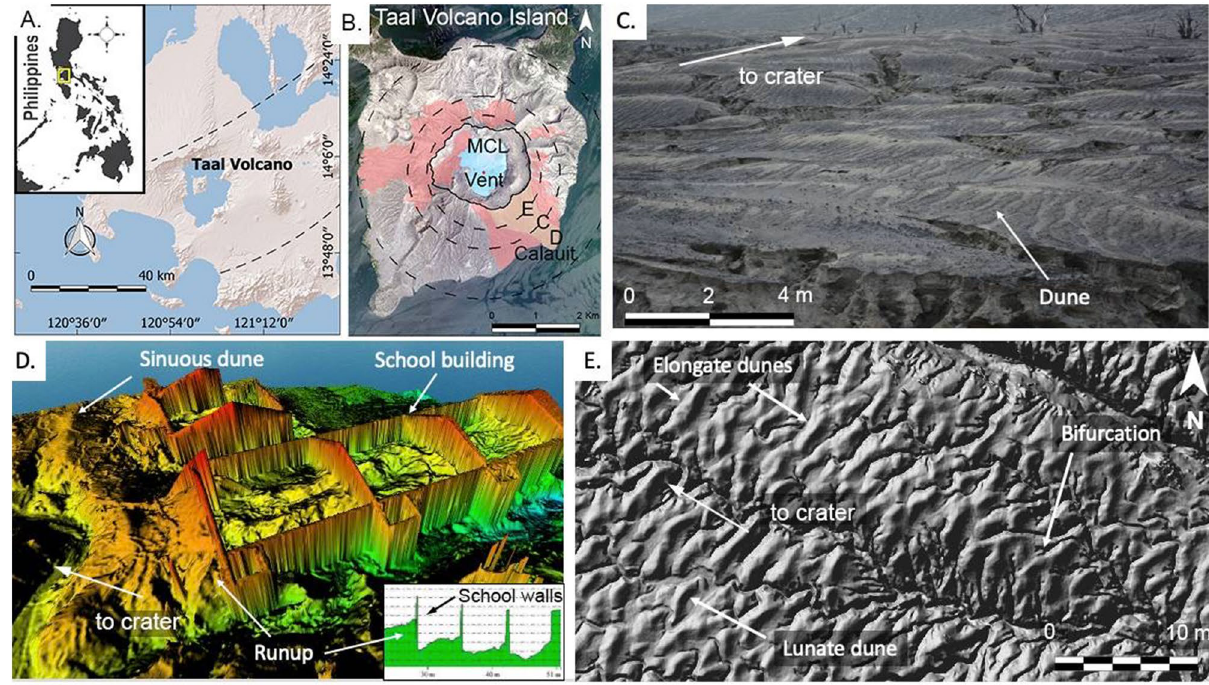
Figure 2. Dunes of TVI. ( A ) General location of Taal Volcano Island. The area within the dashed lines is the Macolod Corridor, a 40-km-wide rift zone 65 . ( B ) Distribution of the 2020 base surge dunes. Circles refer to upper slope, middle slope, and lower slope boundaries. Areas with dune forms identified through satellite imagery are in red. Field validation was done in the southeast flank (yellow portion of map). K3 and ASTI (“Philippine Copyright 2021 by DOST-ASTI”, includes material (c) KARI 2021, Distribution (SI Imaging Services, Republic of Korea), all rights reserved. ( C ) Photograph of the dune field. ( D ) Digital Surface Model of school overwhelmed by base surges. Sinuous dunes and runup of the base surge also occur inside the classrooms. ( E ) Plan view image of dunes showing elongate and lunate dunes. Bifurcation of dunes is also